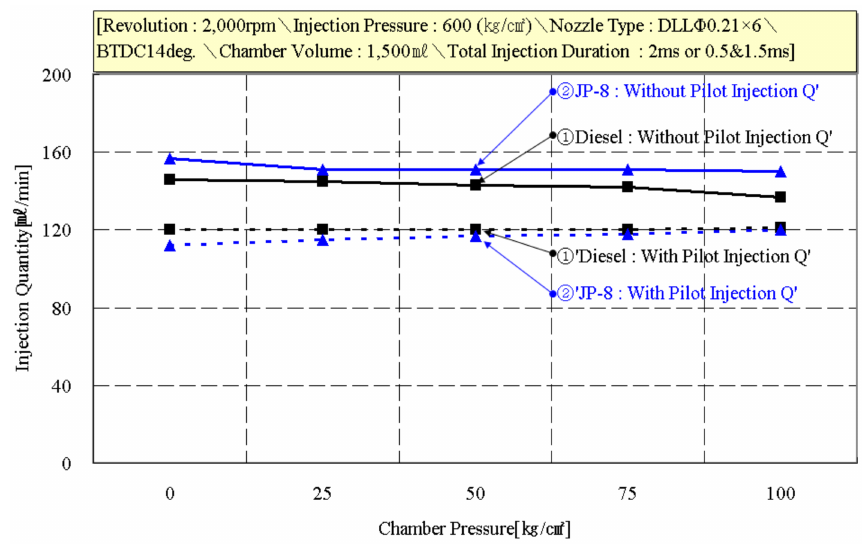
Figure 11. Injection quantity of JP-8 and diesel without pilot injection or with pilot injection.